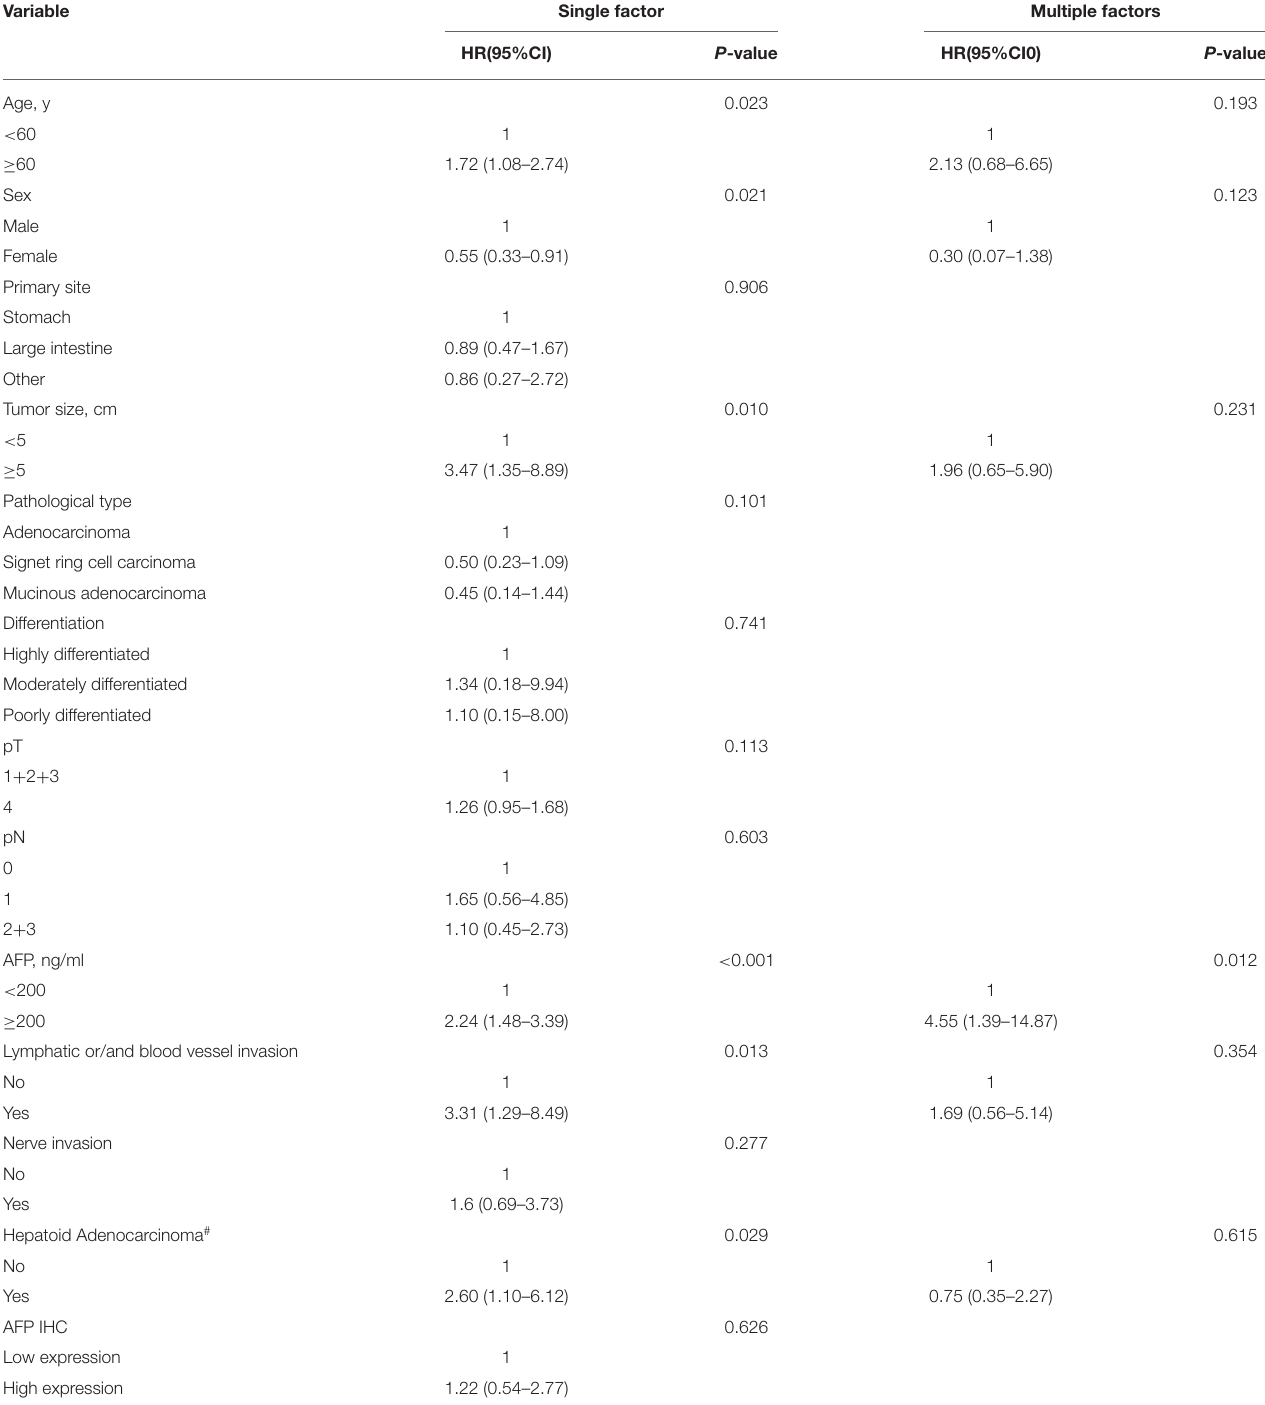
TABLE 5 | Regression analysis for prognostic risk factors of APA-GI liver metastasis.